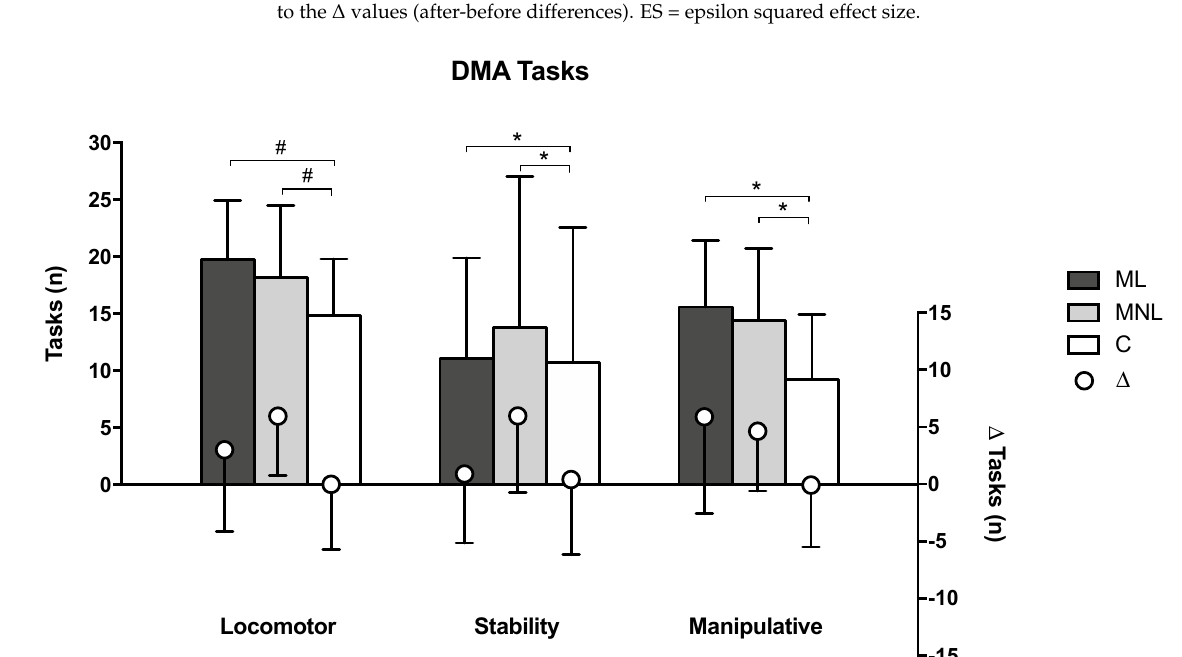
analyzed with the Kruskal–Wallis analysis of variance and Dunn’s post-hoc comparisons to the Δ values (after-before differences). ES = epsilon squared effect size.